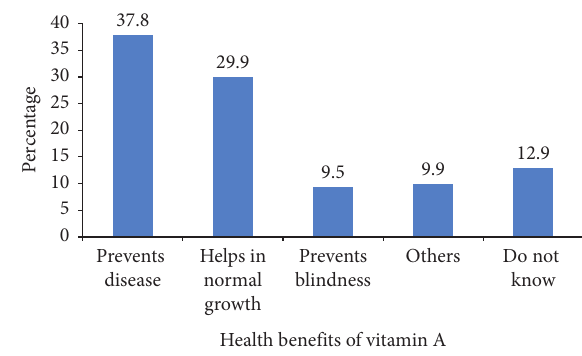
Figure 1: Health benefits of VIT A in Aleta Chuko woreda, 2019.